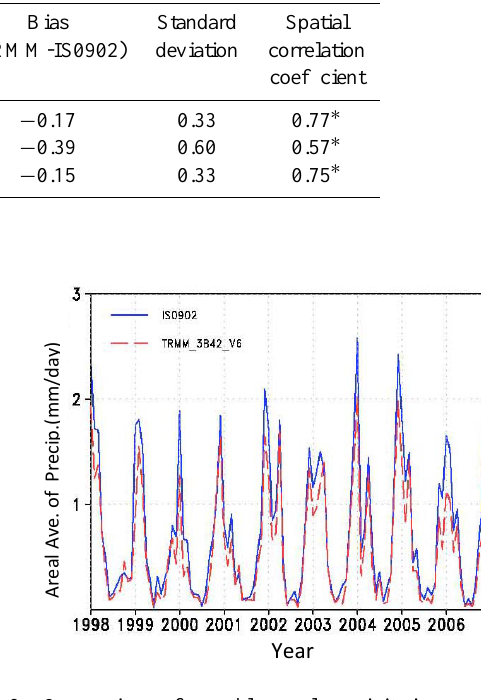
Fig. 9. Comparison of monthly areal precipitation average over Iran (25°-40° N, 45°-60° E) in IS0902 (blue solid line) and TRMM_3B42 (red dashed line) from 1998 to 2006.